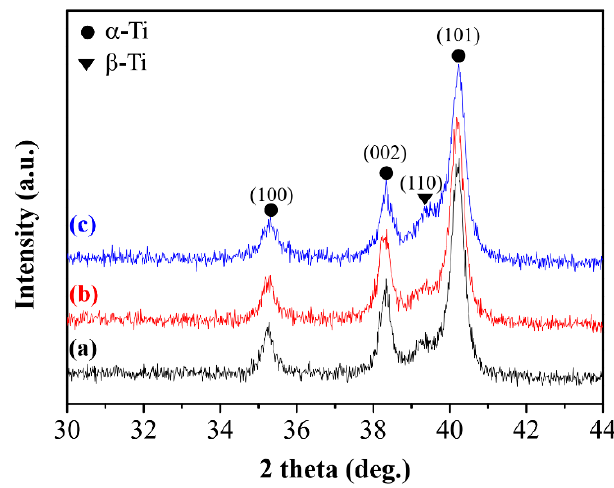
Figure 7. XRD patterns of Ti6Al4V alloy consolidated by vacuum sintering ( a ), capsule-free HIP ( b ), and capsule HIP ( c ).